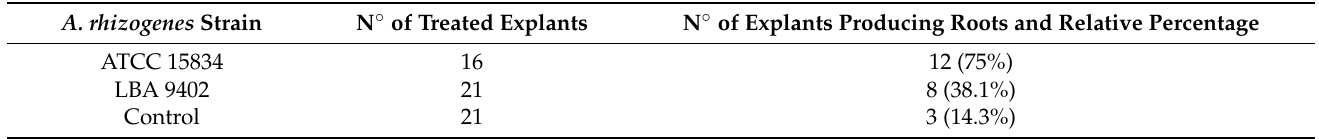
Table 1. Induction of roots by different strains of A. rhizogenes vs. non treated control, 30 days after inoculation a . A. rhizogenes Strain N ◦ of Treated